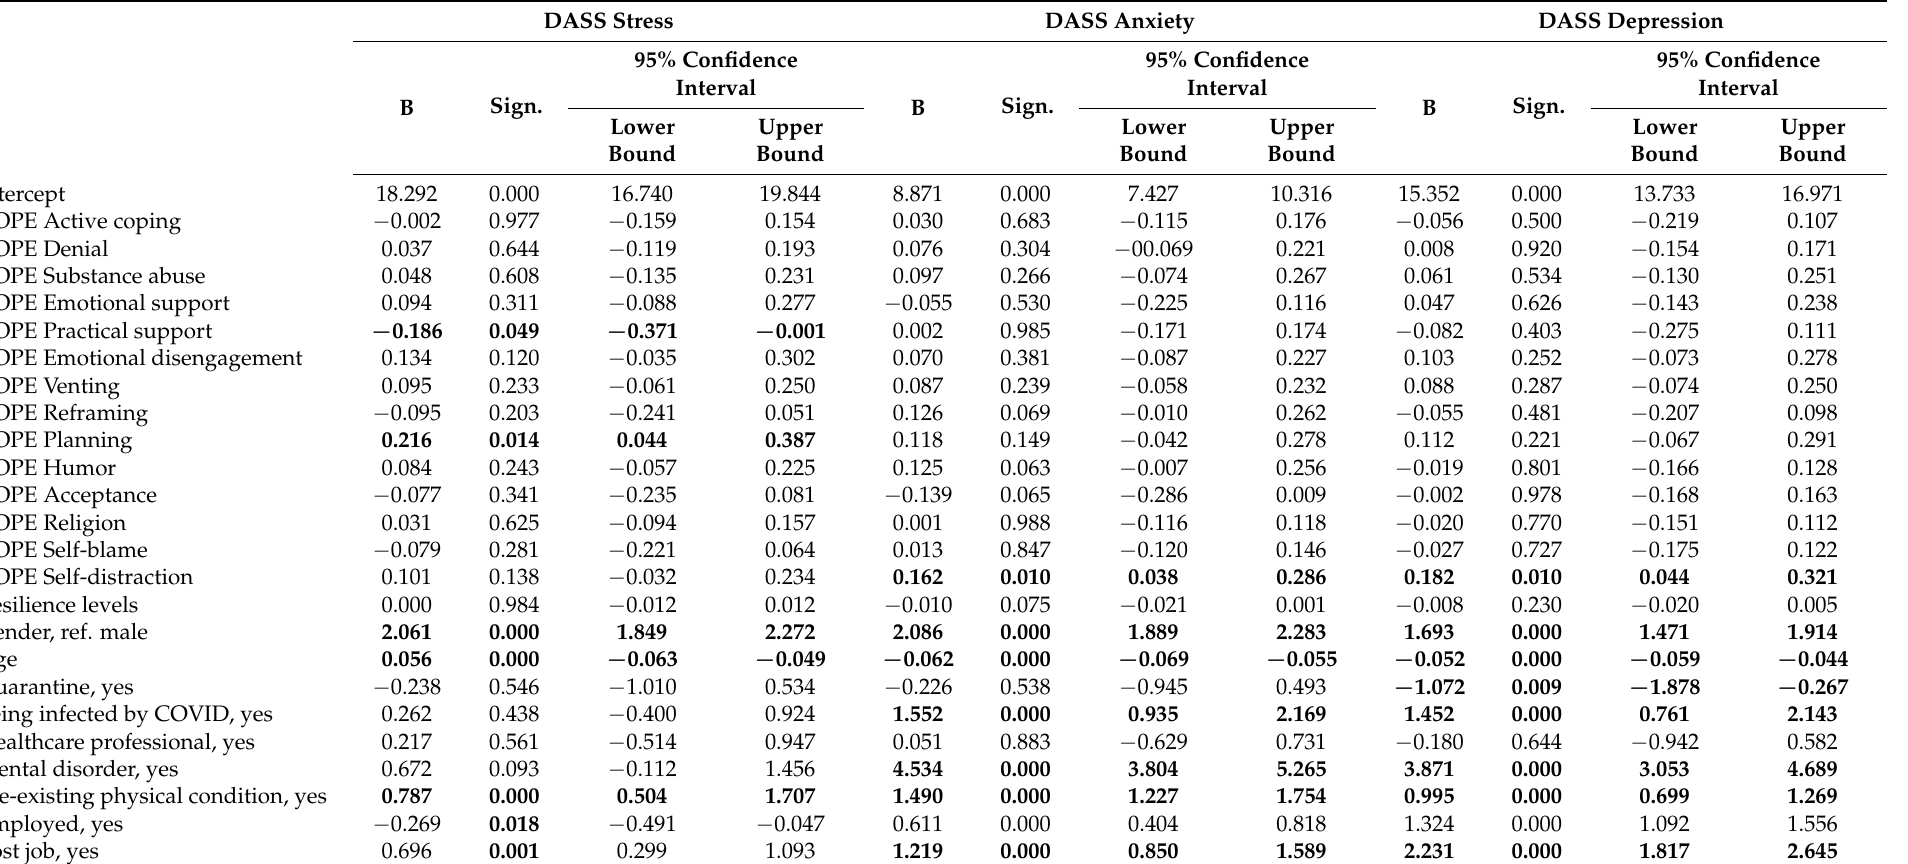
Table 4. Impact of coping strategies and resilience on mental health status. DASS